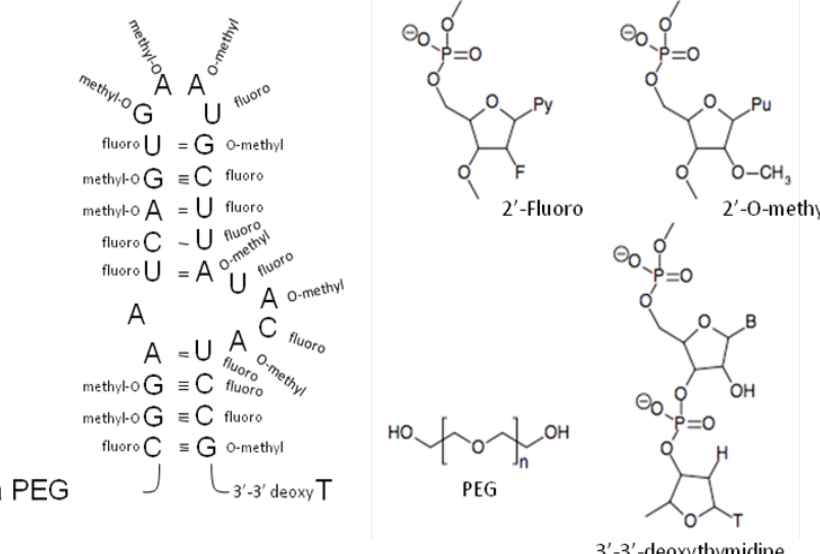
Figure 3. Pegaptanib aptamer. Proposed secondary structure model of the pegaptanib aptamer is indicated on the left. All pyrimidines were 2’-fluoromodified during selection procedure. All purines of the aptamer were 2’- O- methyl-modified after the selection. Additionally 40 kDa polyethylene glycol was added in 5’-end and an inverted 3’-3’- deoxythymidine cap in 3’ the end. Chemical structure of indicated modifications is shown on the right